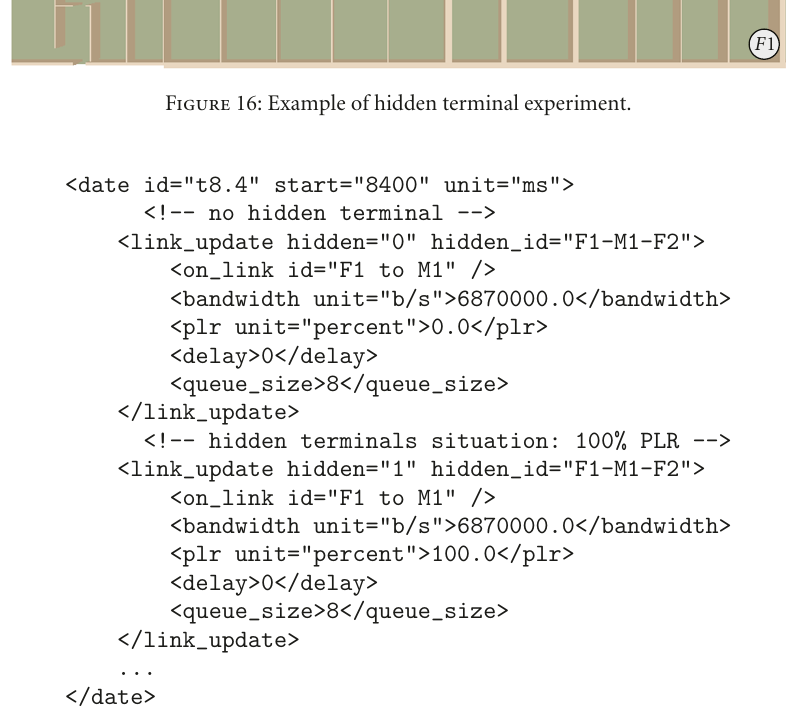
Figure 17: Excerpt of the emulation scenario: two choices for hidden/not hidden tra ffi c